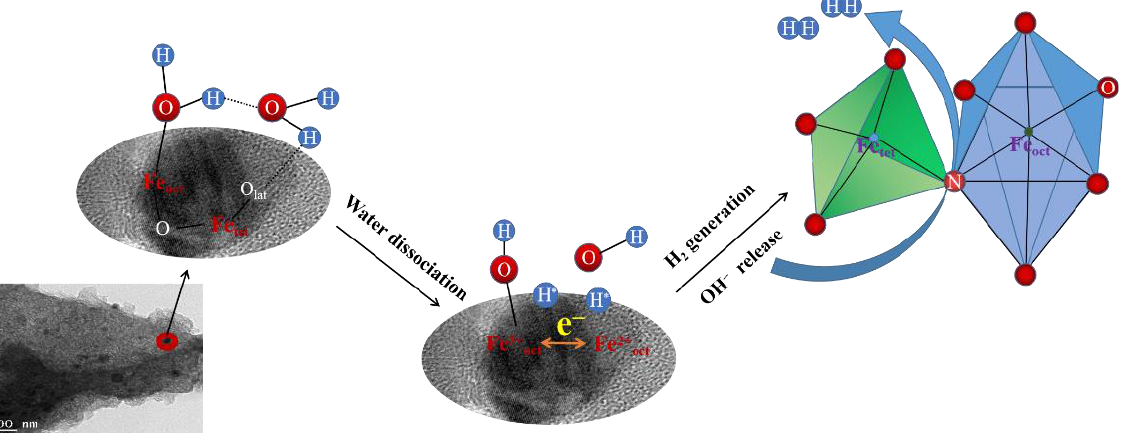
Figure 10. Schematic description of a possible reaction pathway of water dimer dissociation on the surface of N-Fe 3 O 4 catalysts to disclose enhanced HER activity in alkaline media.